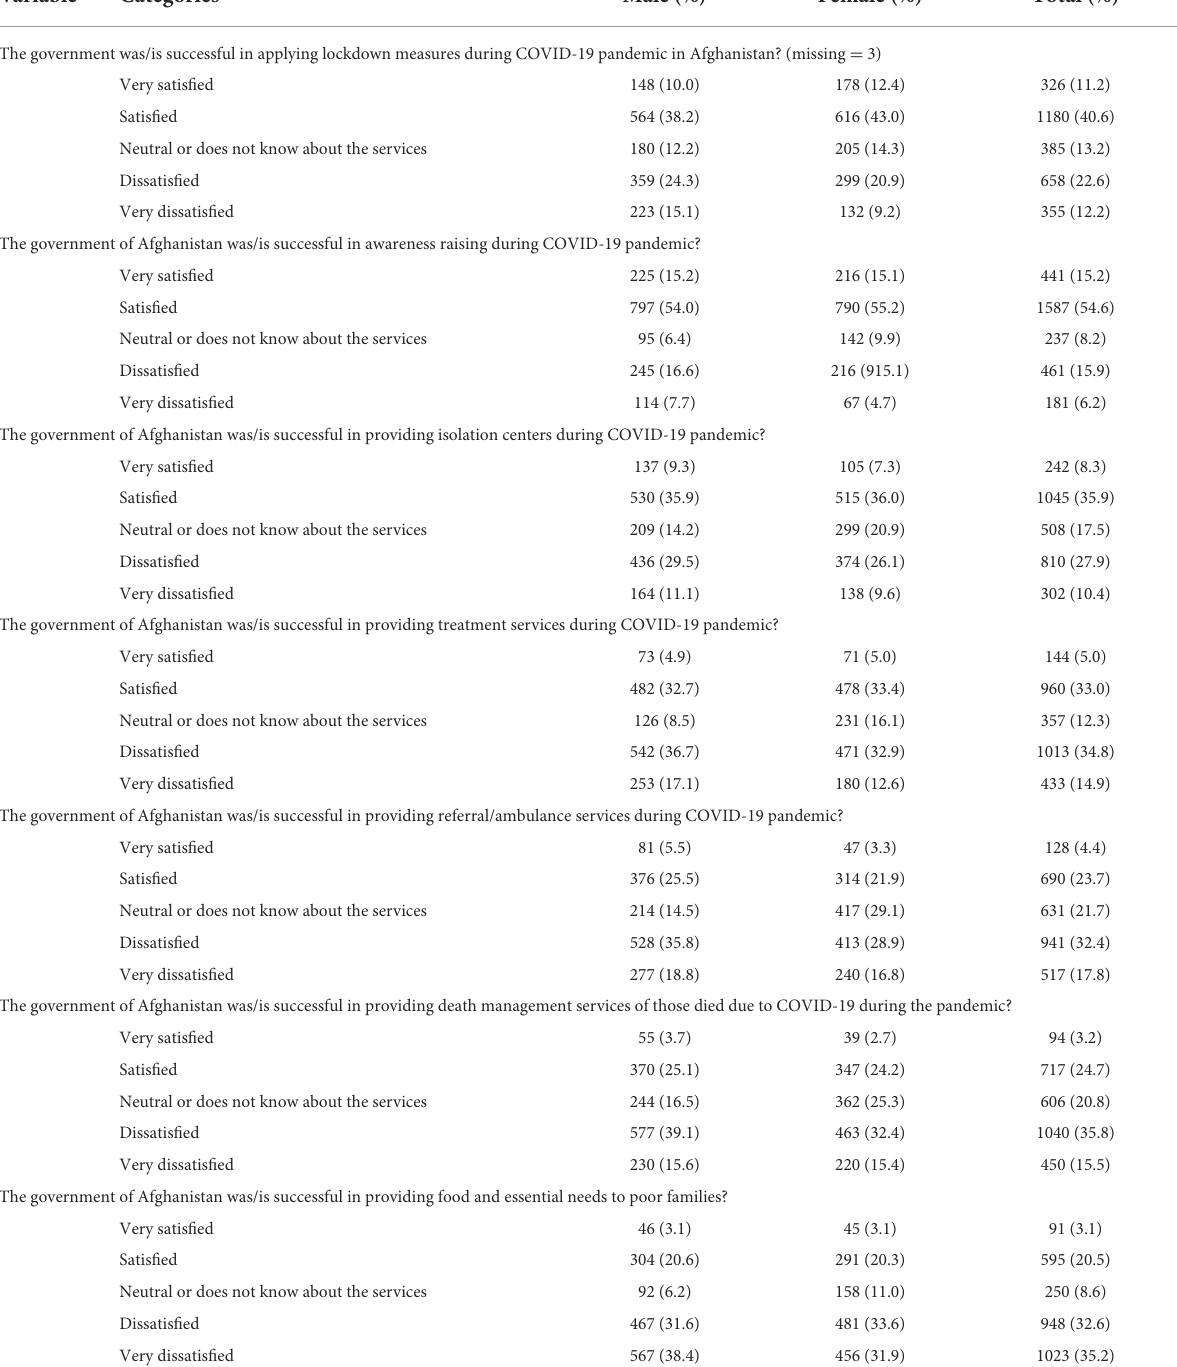
TABLE 10 Level of satisfaction from government by participants related to COVID-19 control and prevention ( N = 2907).